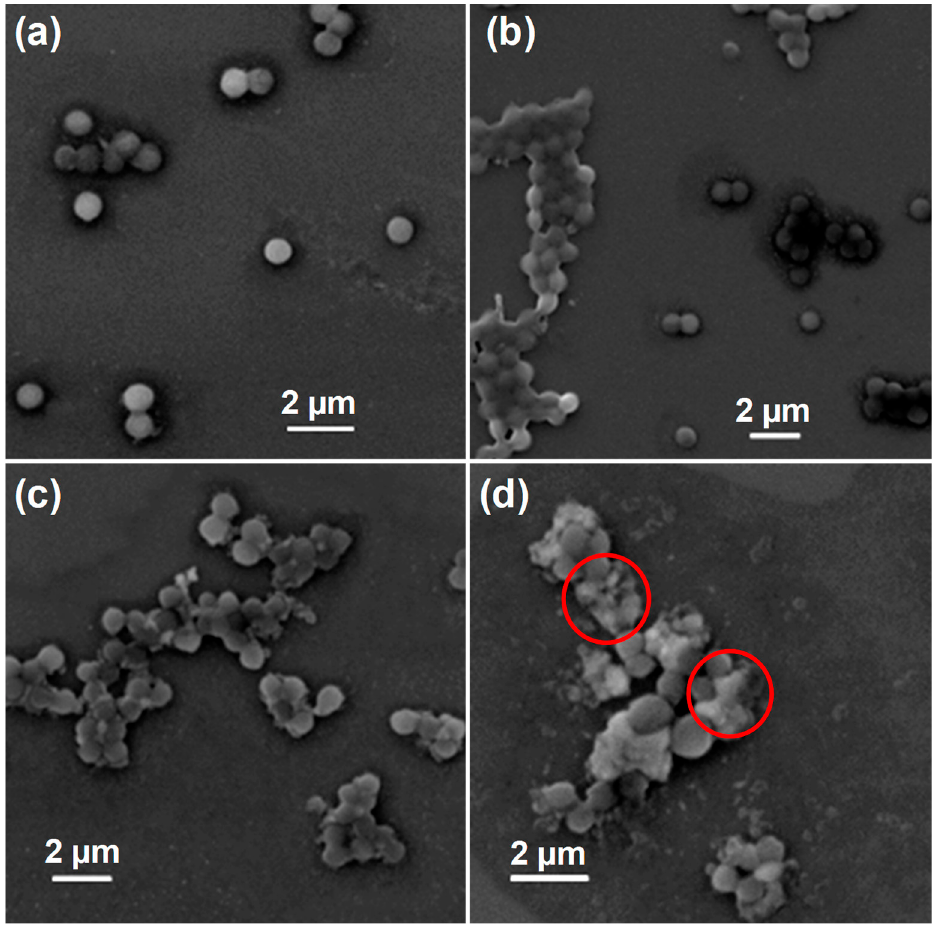
Figure 4. Scanning electron microscopy images of S. aureus after various treatments. ( a ) Untreated, ( b ) LPEV-treated, ( c ) MZ-treated, and ( d ) MZ-LPEV-treated. The red circles indicate morphological changes in bacterial cells.